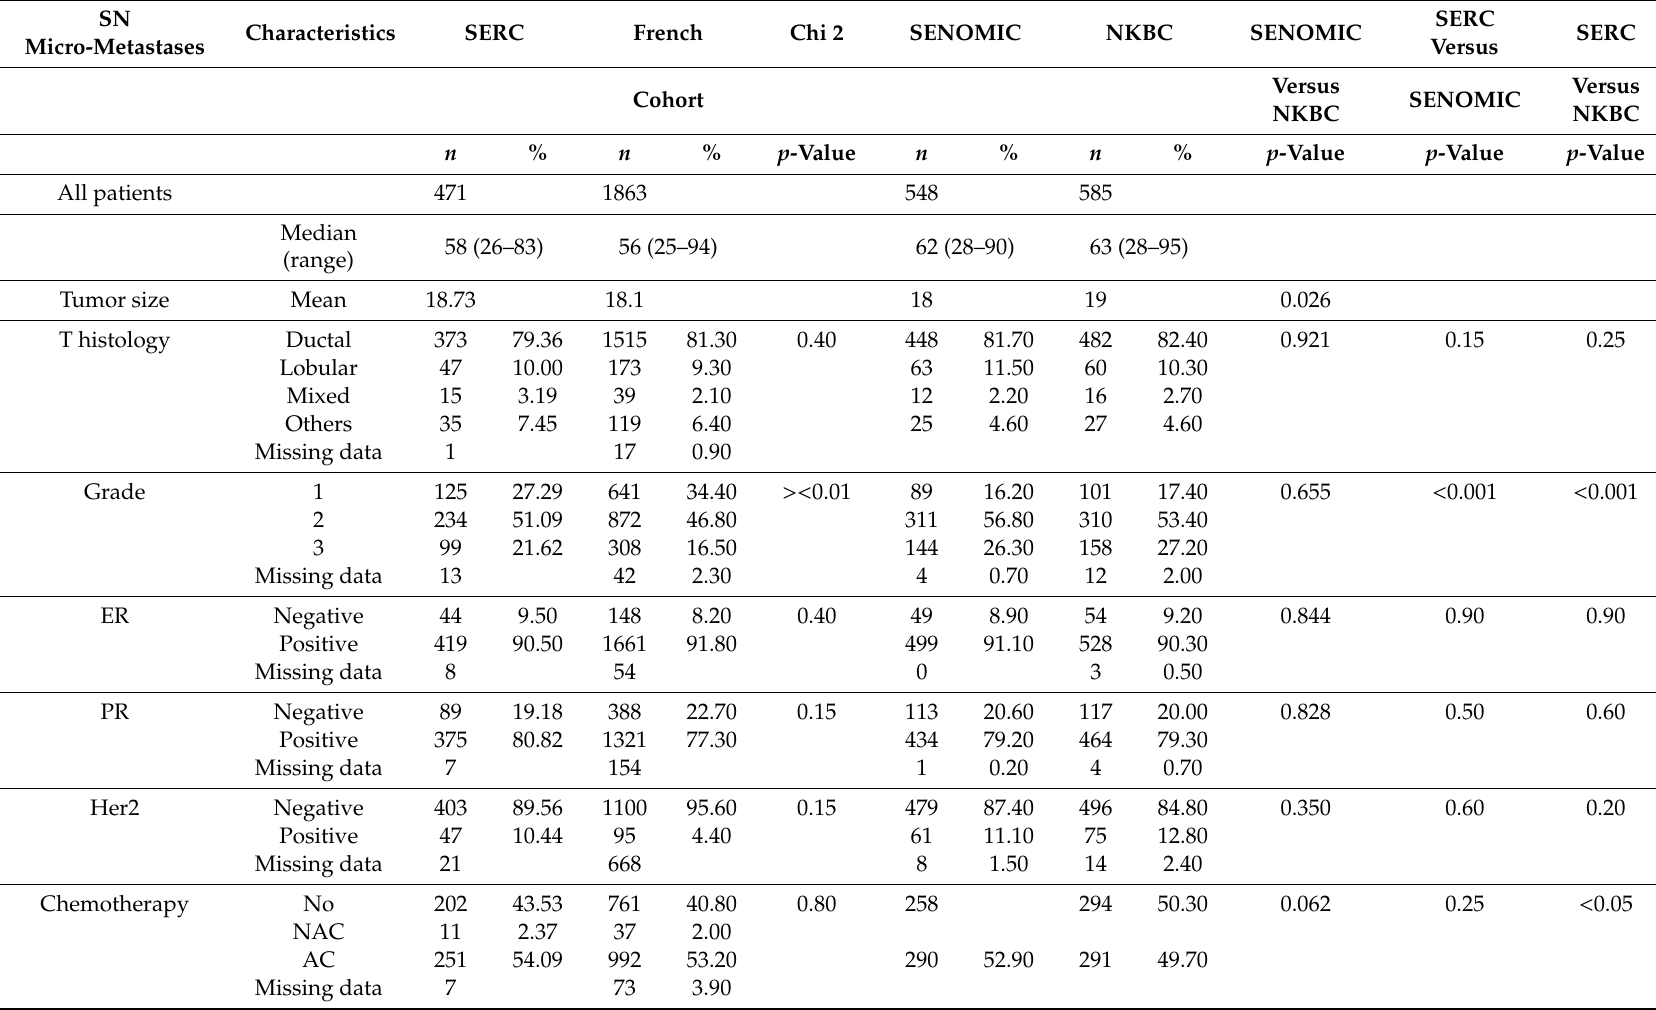
Table 2. Comparison of the French and the Swedish